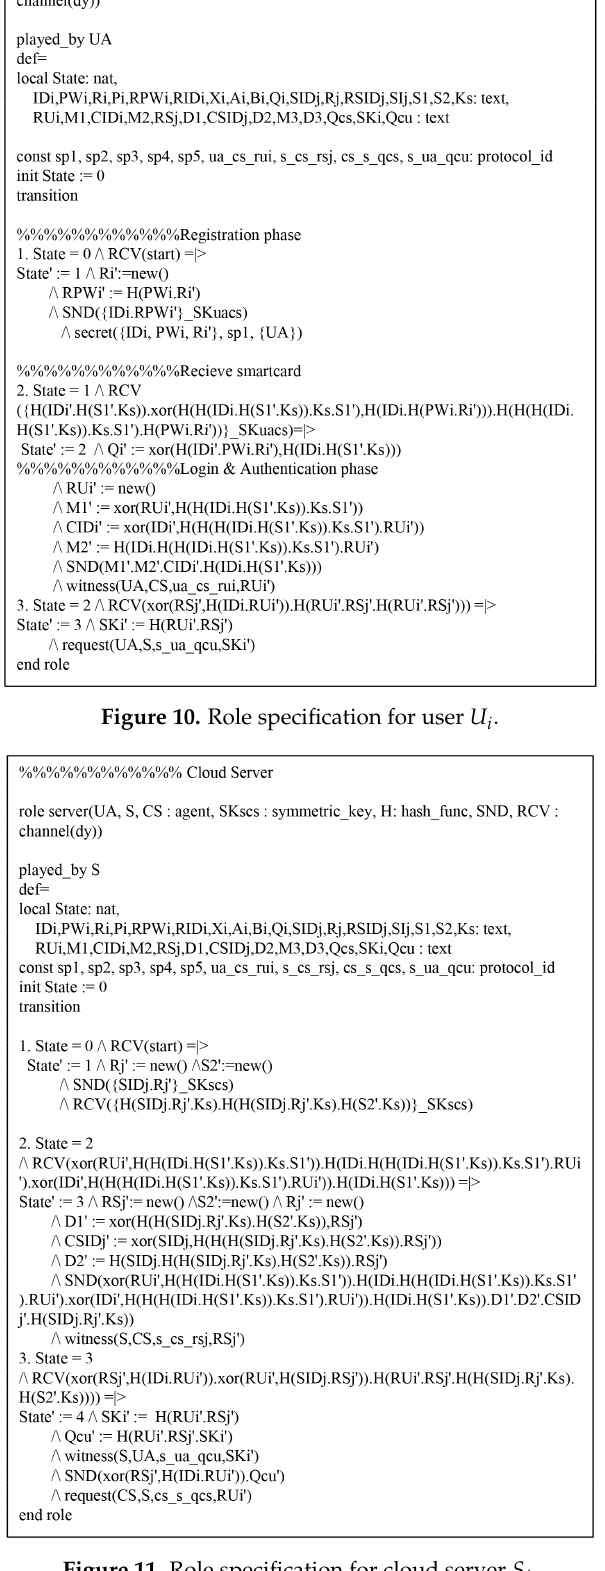
Figure 11. Role specification for cloud server S j